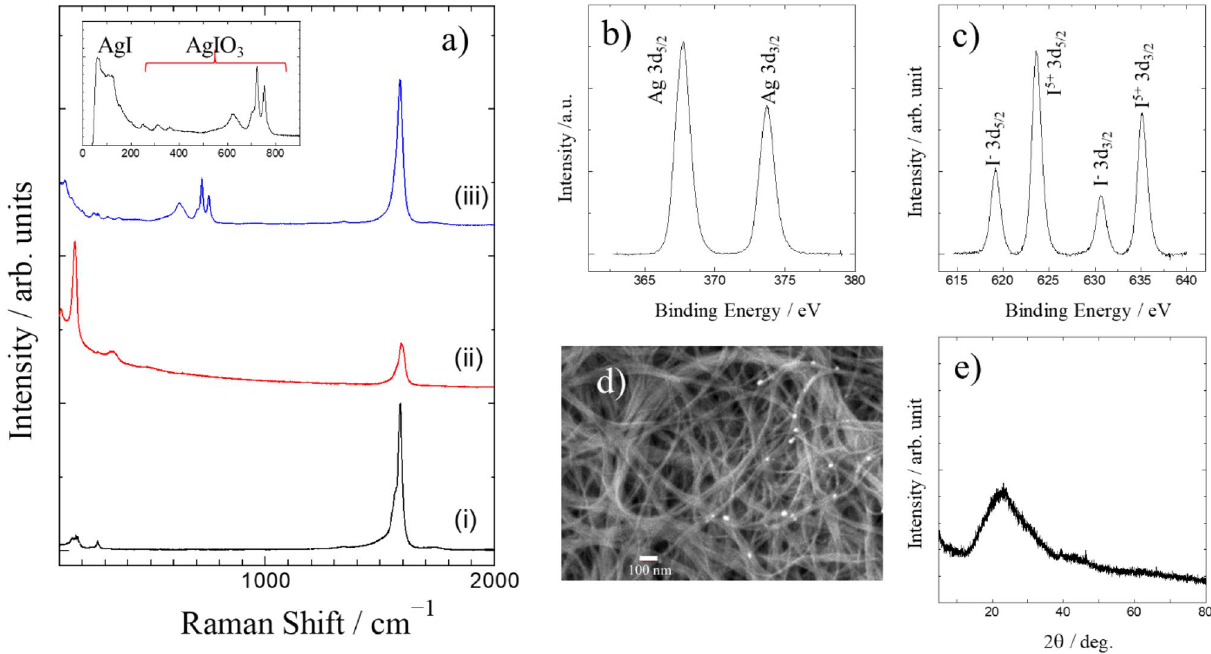
Figure 2. ( a ) Raman spectra of (i) pristine SWCNTs, (ii) I@SWCNT, (iii) AgI-AgIO 3 -SWCNT. The inset shows the low wavenumber region of the Raman spectrum of (iii). ( b ) Ag 3d binding energies and ( c ) I 3d binding energies on the XPS spectra of AgI-AgIO 3 -SWCNT. ( d ) SEM image of AgI-AgIO 3 -SWCNT. e) XRD pattern of AgI-AgIO 3